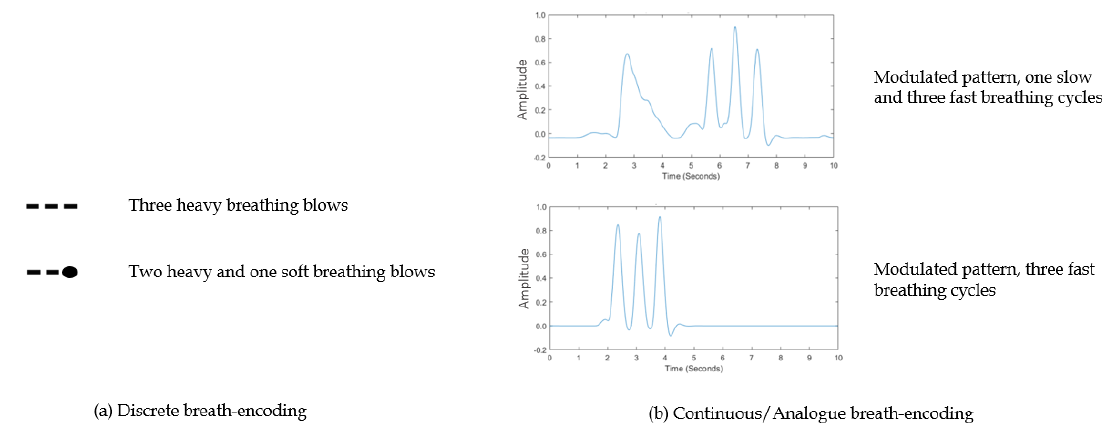
Figure 5. Examples of ( a ) discrete breath encoding, where soft and heavy breathing blows are recorded to encode combinations of zeros and ones, or Morse codes, representing the intended messages, and ( b ) continuous breath encoding, where the speed, amplitude, and phase of breathing are modulated to create patterns representing the intended